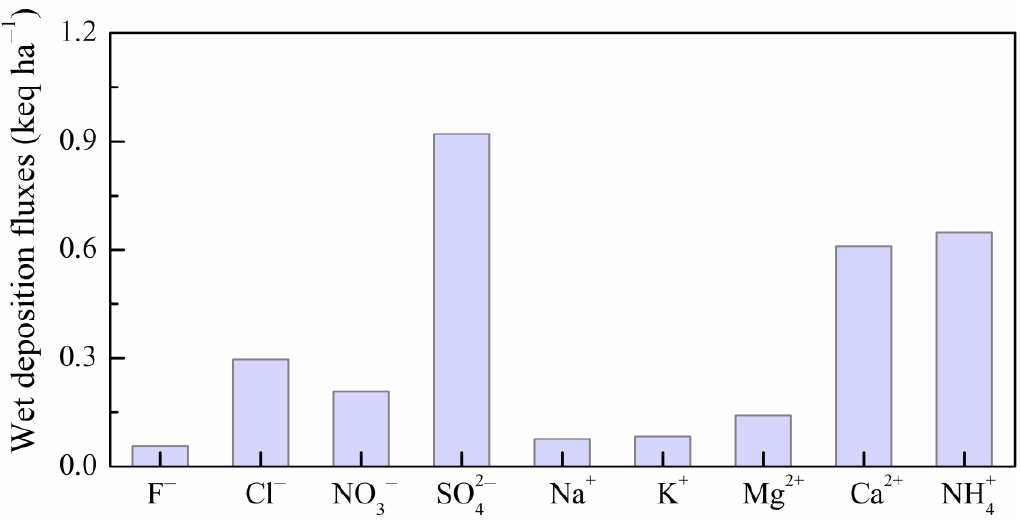
Figure 10. The annual rainwater ions deposition fluxes in the MNKFP.